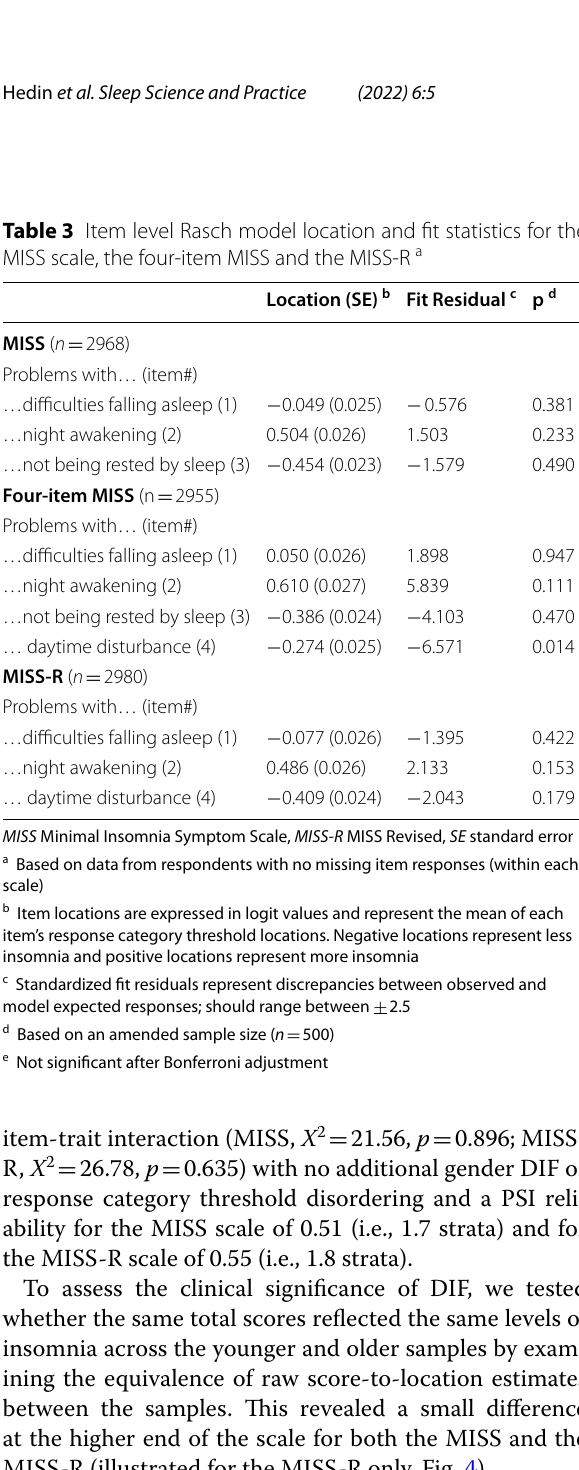
score-to-location estimates of insomnia at a raw score of Table 3 Item level Rasch model location and fit statistics for the